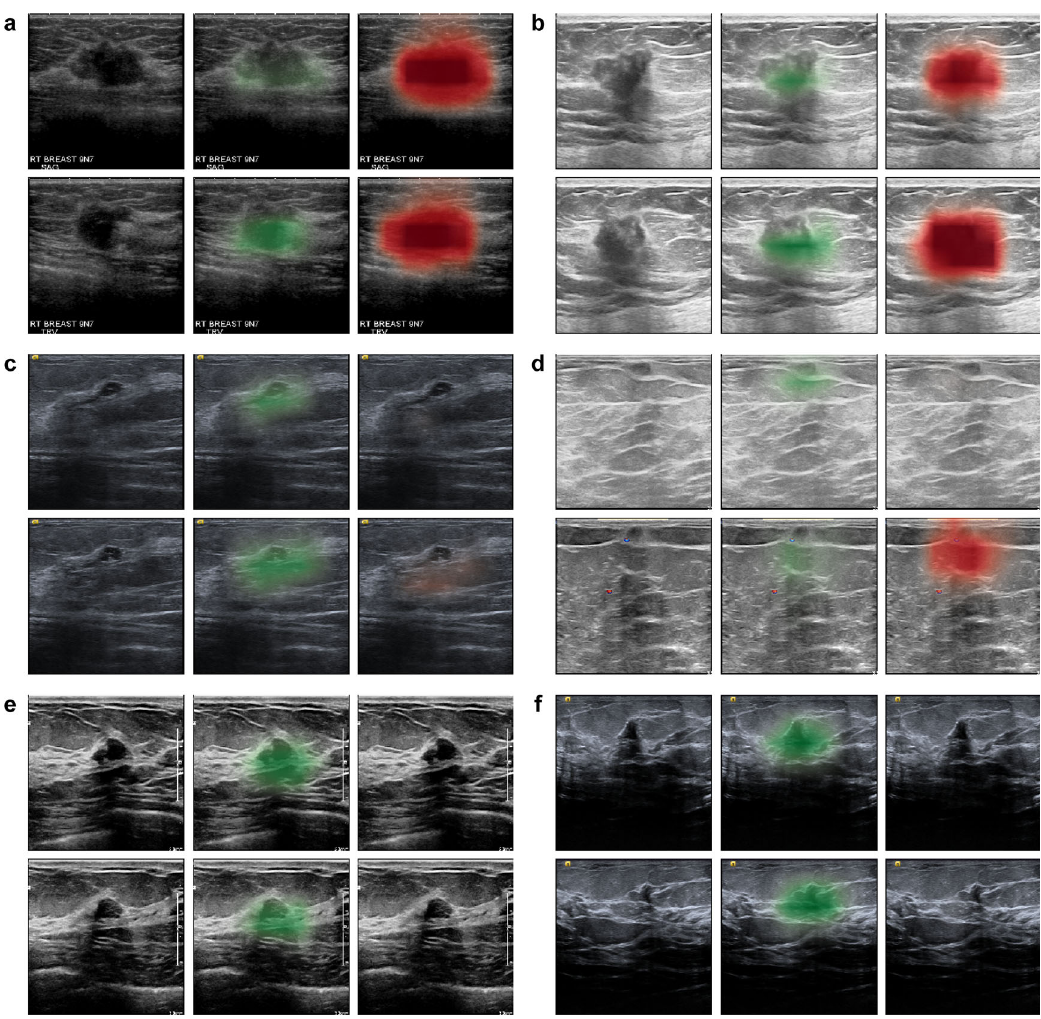
Fig. 3 Qualitative analysis of saliency maps. In each of the six cases ( a – f ) from the reader study, we visualized the sagittal and transverse views of the lesion (left) and the AI ’ s saliency maps indicating the predicted locations of benign (middle) and malignant (right) fi ndings (see Methods section `Deep neural network architecture'). Exams a – c display lesions that were ultimately biopsied and found to be malignant. All readers and the AI system correctly classi fi ed exams a – b as suspicious for malignancy. However, the majority of readers (7/10) and the AI system incorrectly classi fi ed case c as benign. Cases d – f display lesions that were biopsied and found to be benign. The majority of readers incorrectly classi fi ed exams d (9/10), e (10/10), and f (10/10) as suspicious for malignancy and recommended the lesions undergo biopsy. In contrast, the AI system classi fi ed exam d as malignant, but correctly identi fi ed exams e – f as